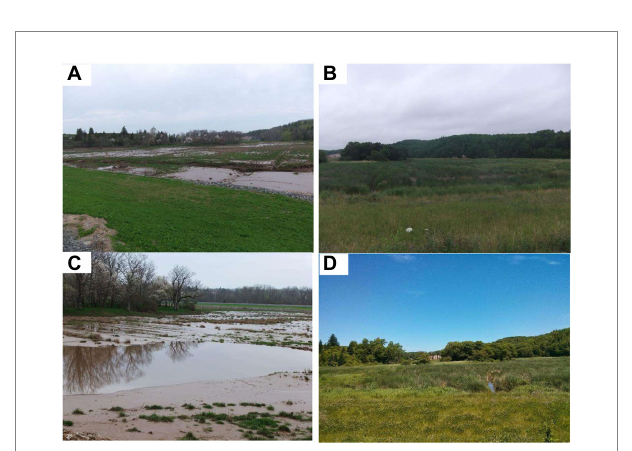
FIGURE 4 St. Croix restoration site (A) marsh landscape Year 1 (2010); (B) marsh landscape Year 3 (2012) post; (C) constructed pond Year 1 post (2010); (D) constructed pond Year 5 (2014) post facing